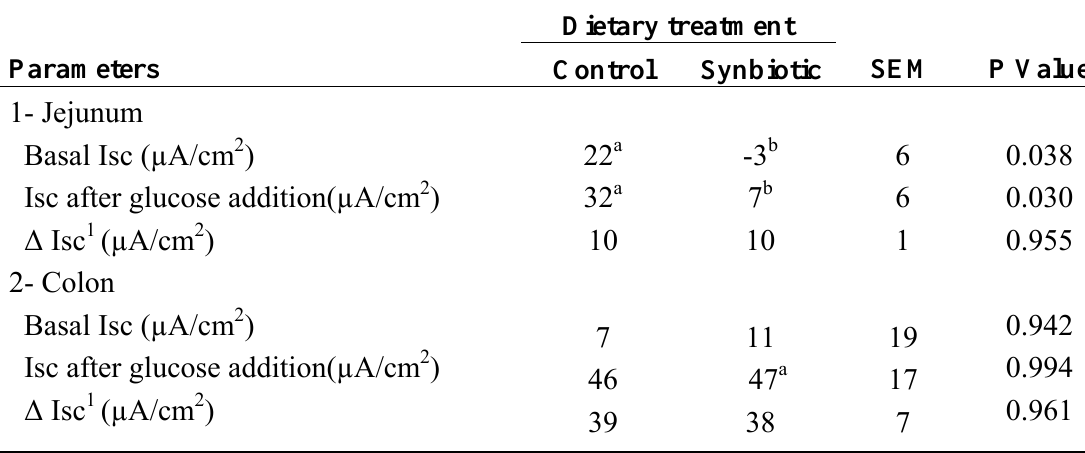
Table 4. Effects of dietary inclusion of synbiotic on short-circuit current (Isc) (µA/cm 2 ) in isolated jejunal and colonic mucosa of broilers after glucose